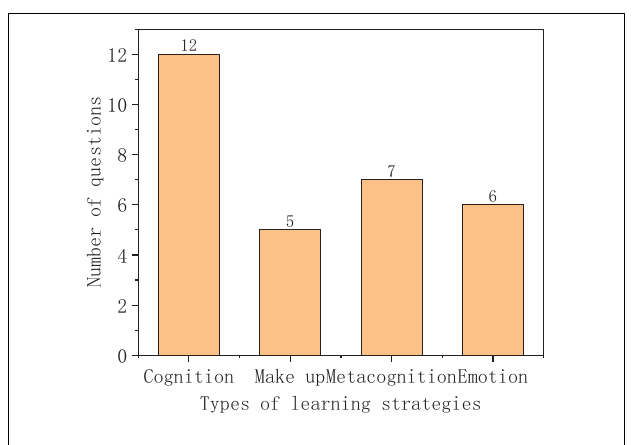
FIGURE 1 | Number of learning